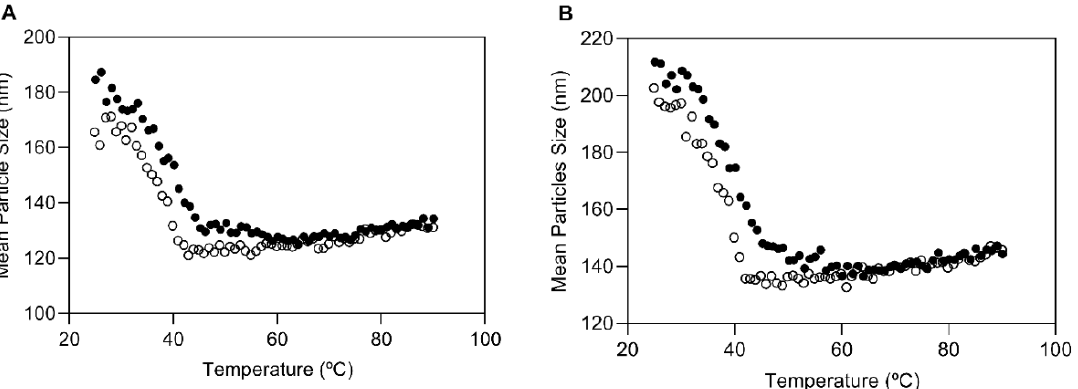
Figure 2. Thermal analysis of naïve NLC ( A ) and AP-loaded NLC ( B ): closed circles from 25 °C to 90 °C and open circles from 90 °C to 25 °C.